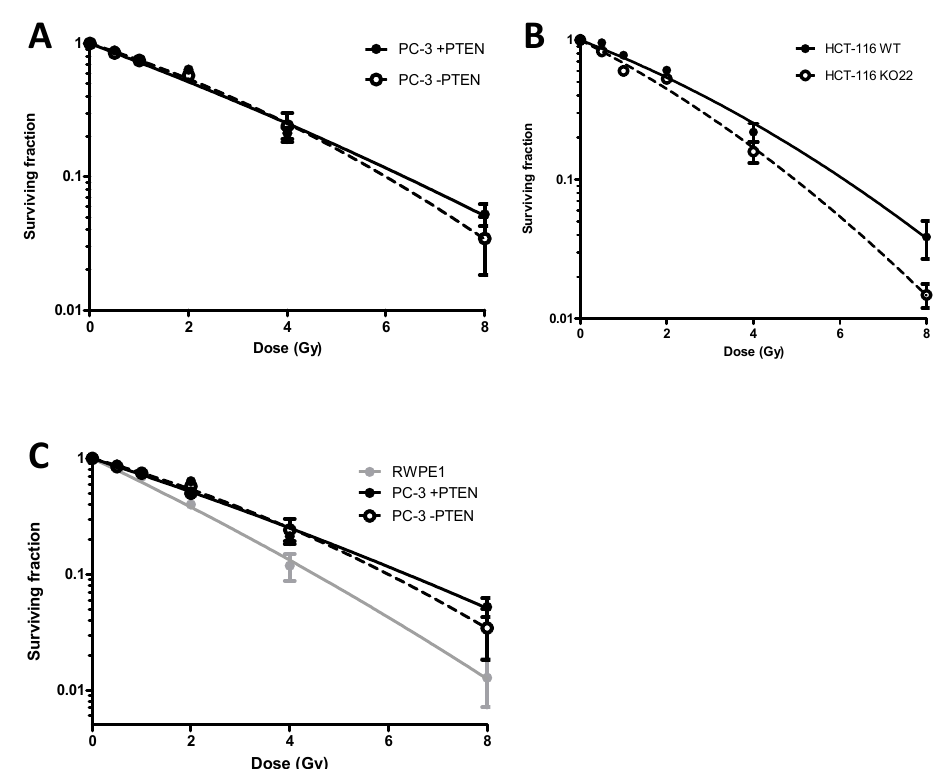
Figure 1. Clonogenic survival curves comparing radiosensitivity of ( A ) PC-3, ( B ) HCT-116, +PTEN ( ● ) and − PTEN ( ■ ) isogenic human tumour cell models and ( C ) RWPE-1 human cell model. Cells were treated with a single radiation dose of 0.5, 1, 2, 4 or 8 Gy. Experiments were performed in triplicate on at least three independent occasions. Error bars represent ± standard error of the mean (SEM). The radiation Sensitizer Enhancement Ratio (SER) were calculated from the mean survival fractions at 4 Gy.